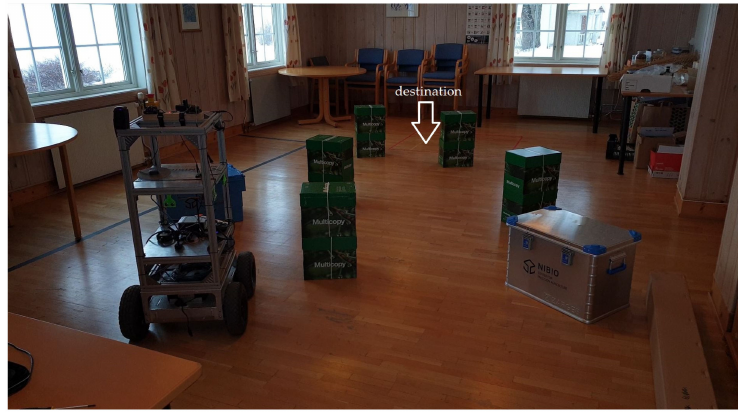
Figure 14. Experimental